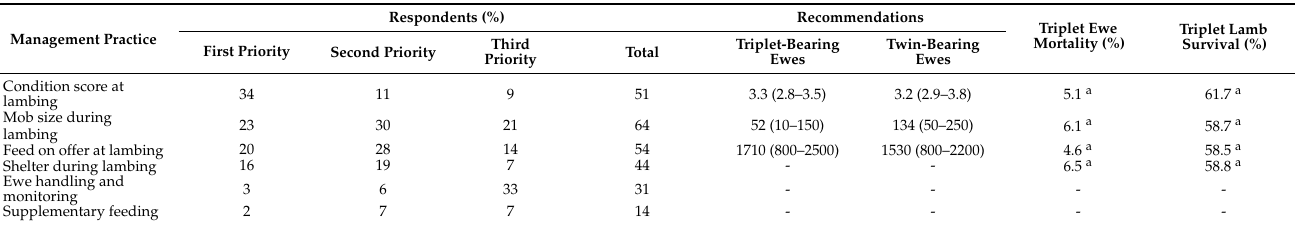
Table 6. The proportion of producers that identified different practices as their first, second and third priorities to reduce mortality of triplet-bearing ewes and/or improve survival of their lambs, their recommendations (average and range) for condition score, mob size and feed-on-offer (kg dry matter/ha) at lambing for twin- and triplet-bearing ewes, and the average mortality of triplet-bearing ewes and survival of their lambs for producers that identified the management practice as their first priority. Data were collected from 64 participants of the benchmarking surveys conducted in 2017 and 2018 for producers that had pregnancy scanned to identify triplet-bearing ewes and managed them separately from twin-bearing